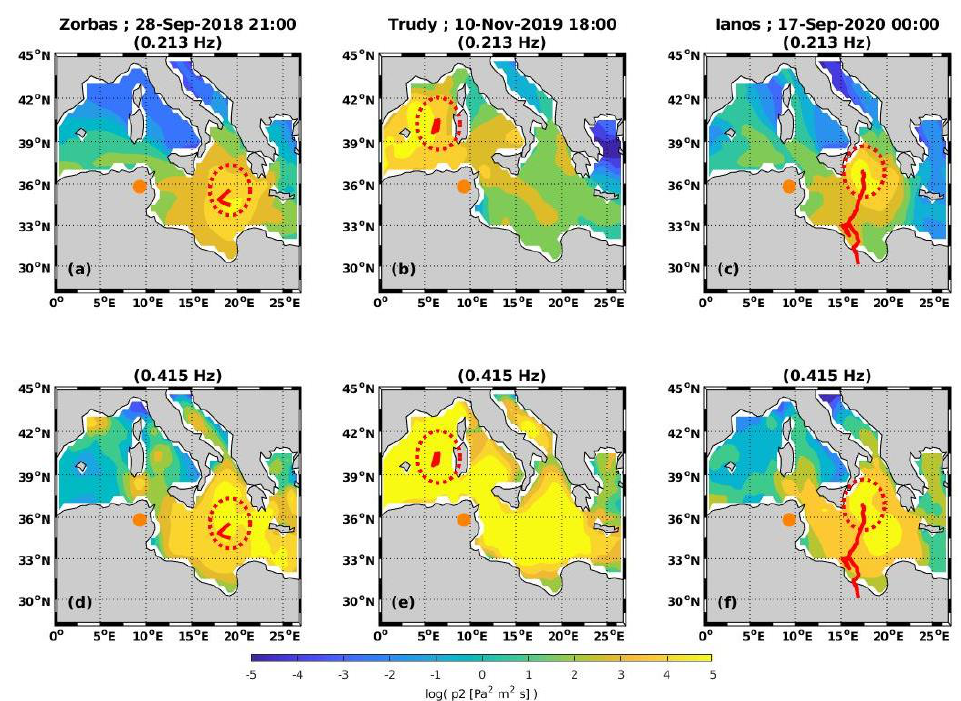
Figure 17. Maps of the equivalent surface pressure spectral density (proportional to the Hasselmann integral) in Pa 2 m 2 s for Zorbas ( a , d ), Trudy ( b , e ), and Ianos ( c , f ) at two different acoustic frequencies: 0.213 Hz ( top row ) and 0.415 Hz ( bottom row ). The orange circle shows the position of the IS48 station in Tunisia.